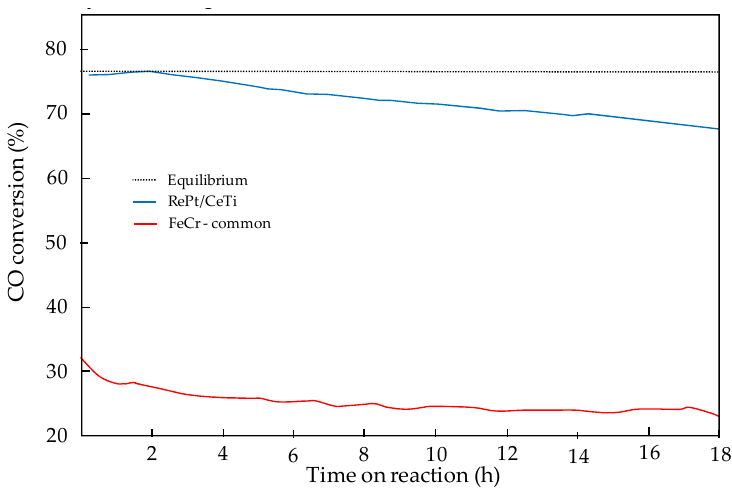
Figure 19. Comparison of CO conversion over the WGS catalyst developed in DEMCAMER and state ‐ of ‐ the ‐ art Fe/Cr catalyst (400 °C, SV = 23,230 L ∙ h − 1 ∙ kg − 1 ) [18].